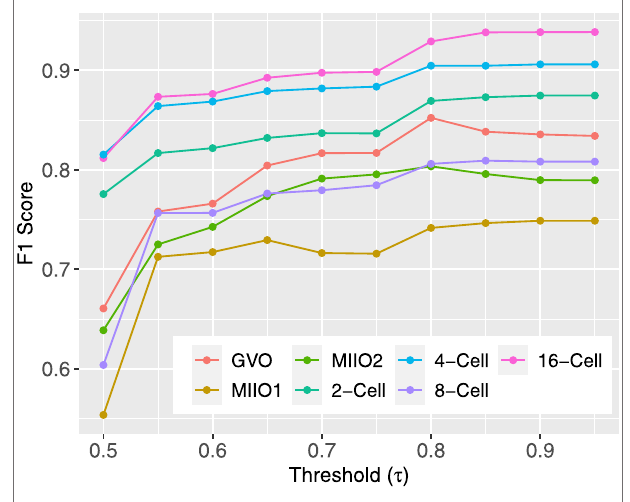
FIGURE 4 | F1 score from the use of varying threshold τ .